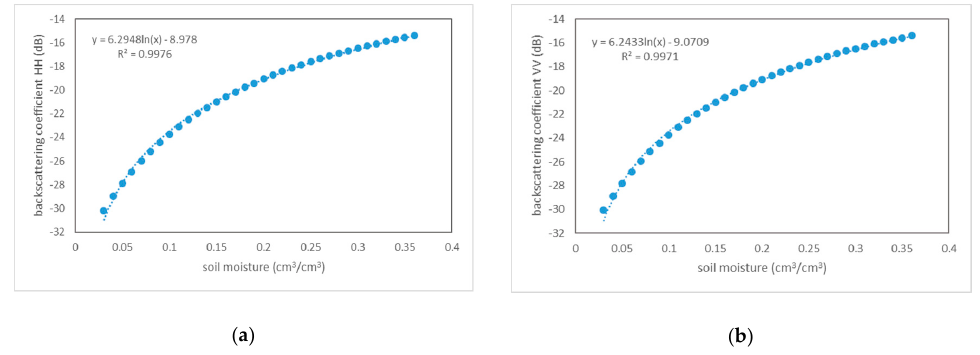
Figure 10. Responses of soil moisture and soil backscattering coefficients. ( a ) HH polarization; ( b ) VV polarization.